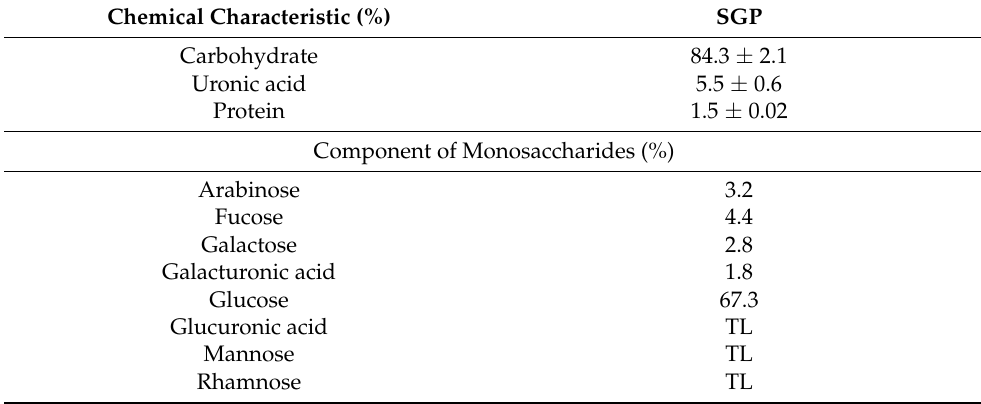
Figure 2. Chemical properties and monosaccharide composition of SPG. ( A ) Total carbohydrate, uronic acid, and protein levels in SGP. Bars indicate means ± standard deviation. ( B ) Overlaid chromatogram of PMP-labeled standard and SGP. (Ara, arabinose; Fuc, fucose; Gal, galactose; GalA, galacturonic acid; Glc, glucose; GlcA, glucuronic acid; Man, mannose; Rha, rhamnose). Table 1. Chemical properties of SGP isolated from heat-processed